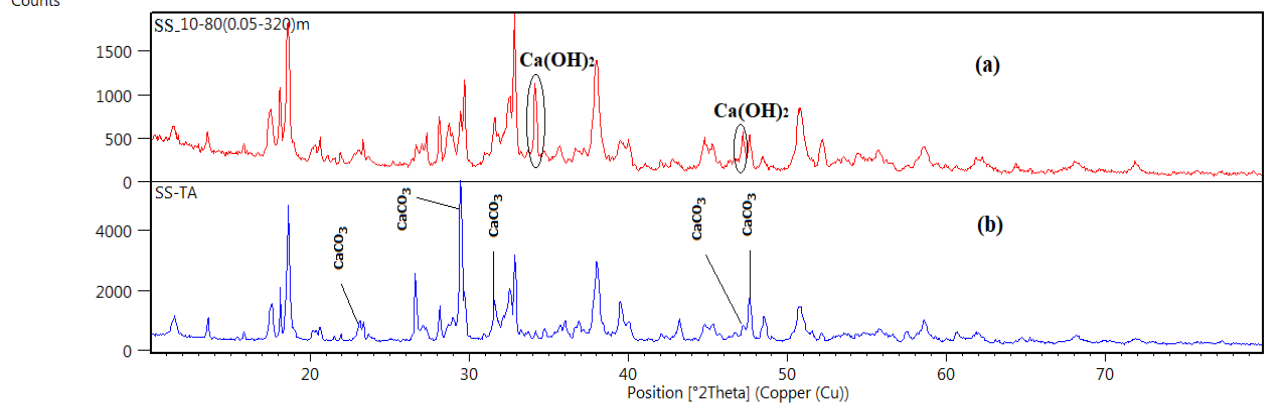
Figure 13. XRD patterns of raw steel slag after adsorption ( a ), and SS–TA before adsorption ( b ).